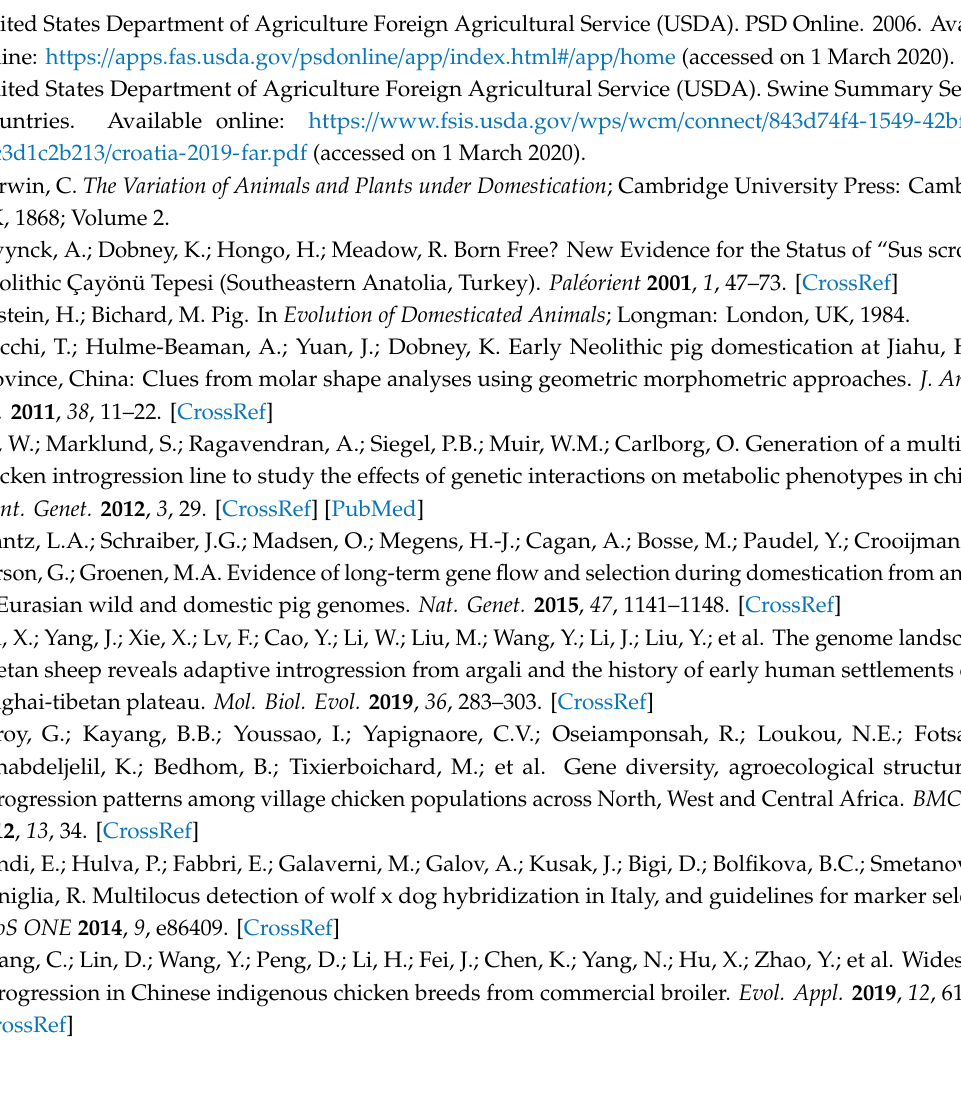
Figure S1: PCA results including outgroup (warthogs). Figure S2: Genetic structure including outgroup (located at the far right of the plots) from K = 2 to 9. Figure S3: PCA results for Chinese